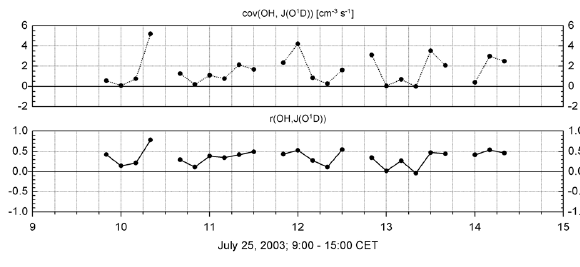
43 47 Fig. 8. Covariances (OH 0 i J(O 1 D) 0 i ) and correlation coefficient at 37m height for 25 July 2003, 09:00– Fig. 8. Covariances (OH 0 i J(O 1 D) 0 i ) and correlation coefficient at 15:00CET. 37m height for 25 July 2003, Figure 8. Covariances ( '1' )( ) and correlation coefficient at 37m height for 25 July ii DOJOH 2003, 9:00 – 15:00 CET.